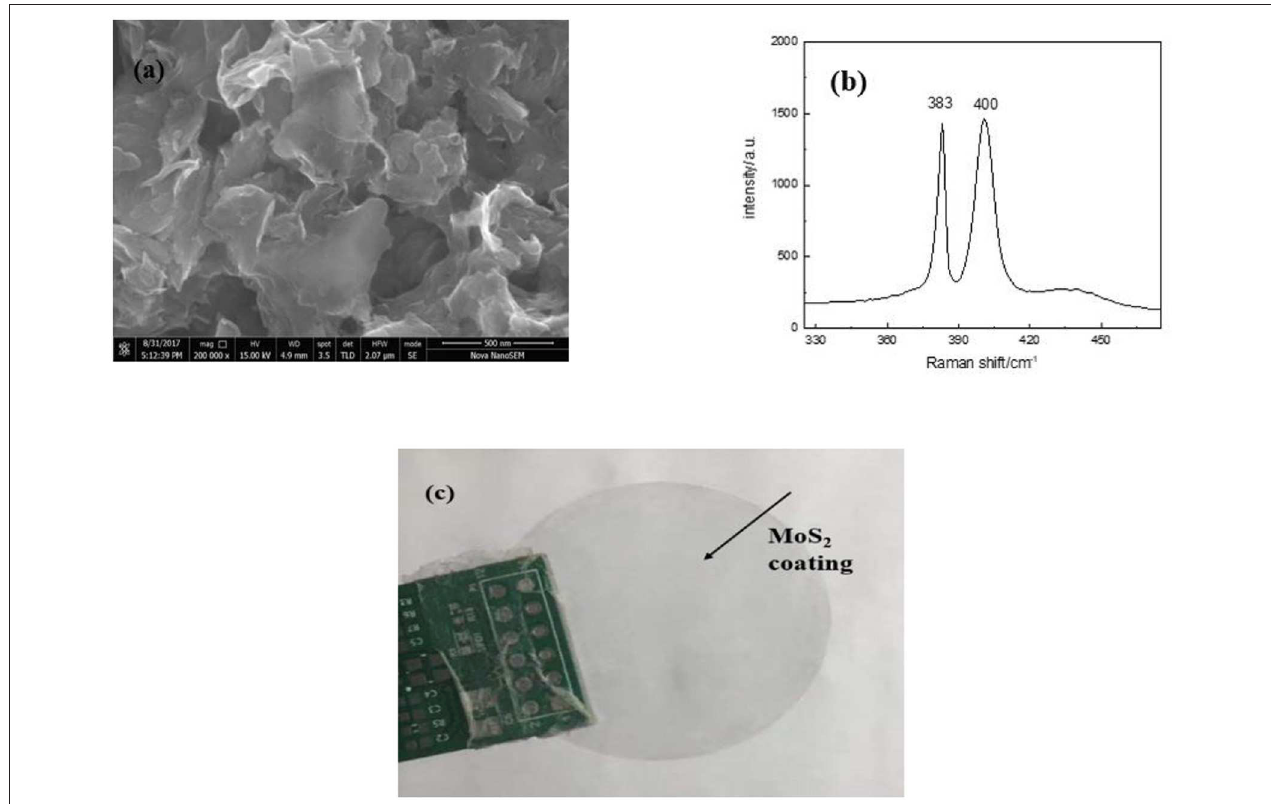
FIGURE 1 | (a) Electron micrograph of MoS 2 . (b) The Raman spectrum of MoS 2 . (c) MoS 2 saturable